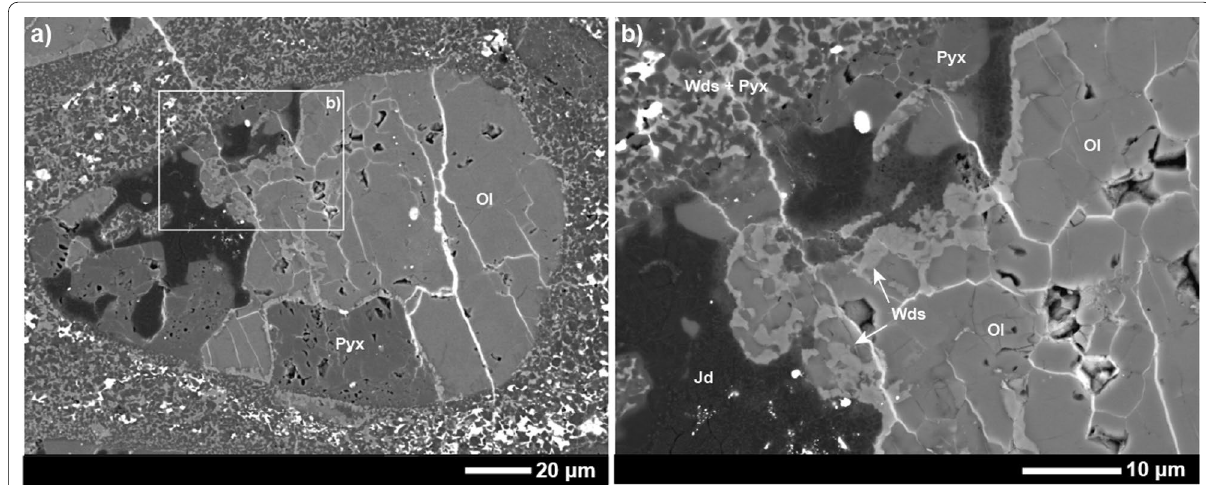
Fig. 3 Backscattered electron (BSE) images of wadsleyite. a A chondritic fragment in the shock-melt vein of Yamato (Y) 000973 L5 ordinary chondrite. b A high-magnification image of a white-colored box in a . A part of olivine in the fragment has been replaced with polycrystalline wadsleyite. The matrix of the shock-melt vein consists of wadsleyite and low-Ca pyroxene. Ol: olivine, Pyx: Low-Ca pyroxene, Wds: wadsleyite, Jd: